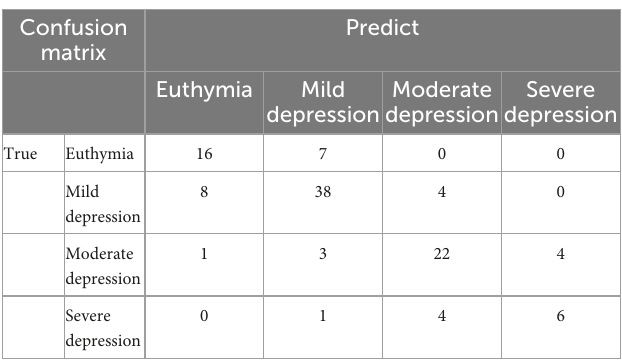
TABLE 4 Confusion matrix of the four-level depression severity classification of ALL-ALL.